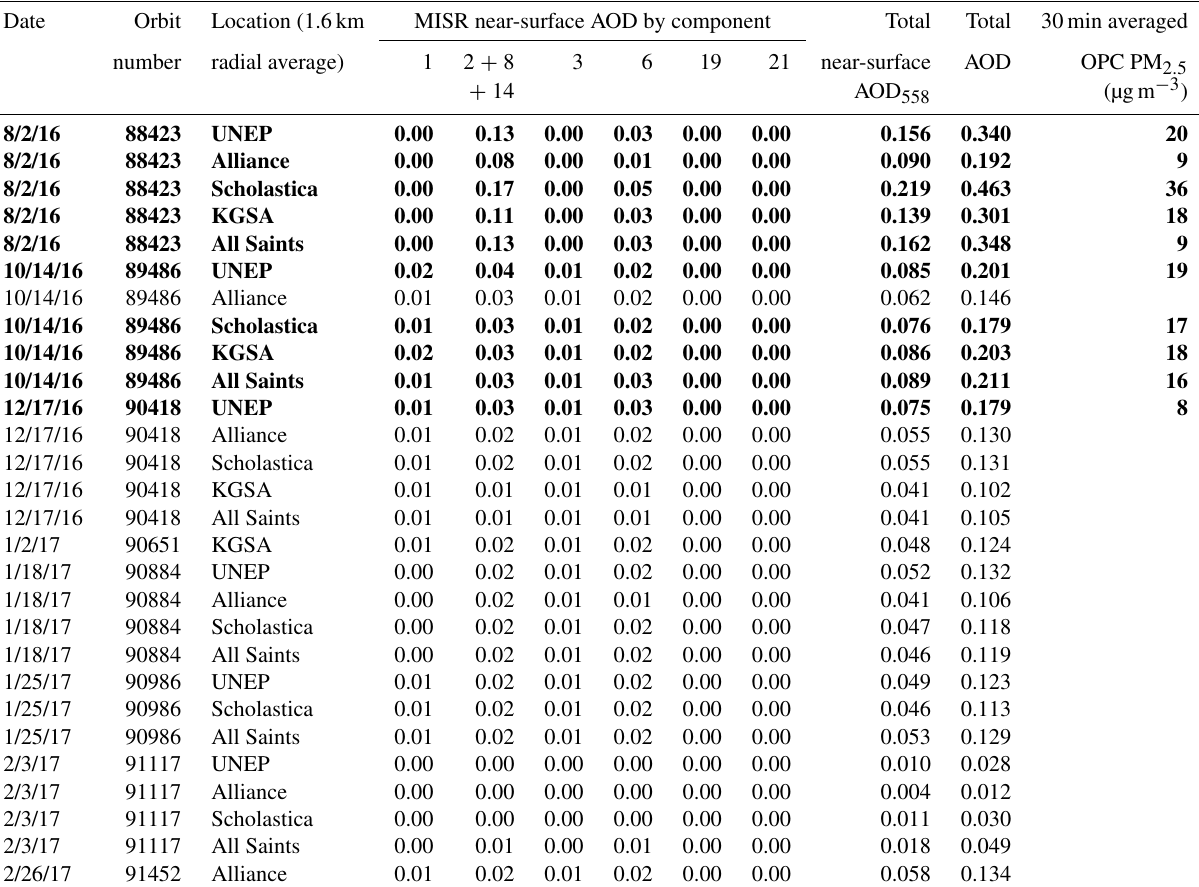
Table 1. Successful near-surface MISR aerosol optical depth retrievals for each MISR aerosol component (including the aggregate scaled AOD from components 2, 8 and 14), the total near-surface MISR AOD and the total MISR AOD, averaged over a radial distance of 1.6km 2 from each surface-monitoring site. These values were obtained for each of the 28 coincident observations from the MISR research algorithm, run with the standard universe of 74 mixtures. The AOD is set to zero for aerosol components not present among the MISR-retrieved aerosol types. The retrieved amounts of components 19 and 21 were negligible or zero in all the retrievals. Near-surface values were obtained by scaling total-column AOD based on GEOS-Chem simulated aerosol vertical distributions. The 10 rows in bold correspond to observations that have a MISR total AOD (sum of the AOD of the eight MISR aerosol components) > 0 . 15. The corresponding surface PM 2 . 5 from the ground-based OPC for the 10 favorable MISR retrievals is also presented. Note that we have rounded the PM 2 . 5 values to the nearest integer to acknowledge the uncertainties in the OPC PM 2 . 5 measurements. Dates are given as